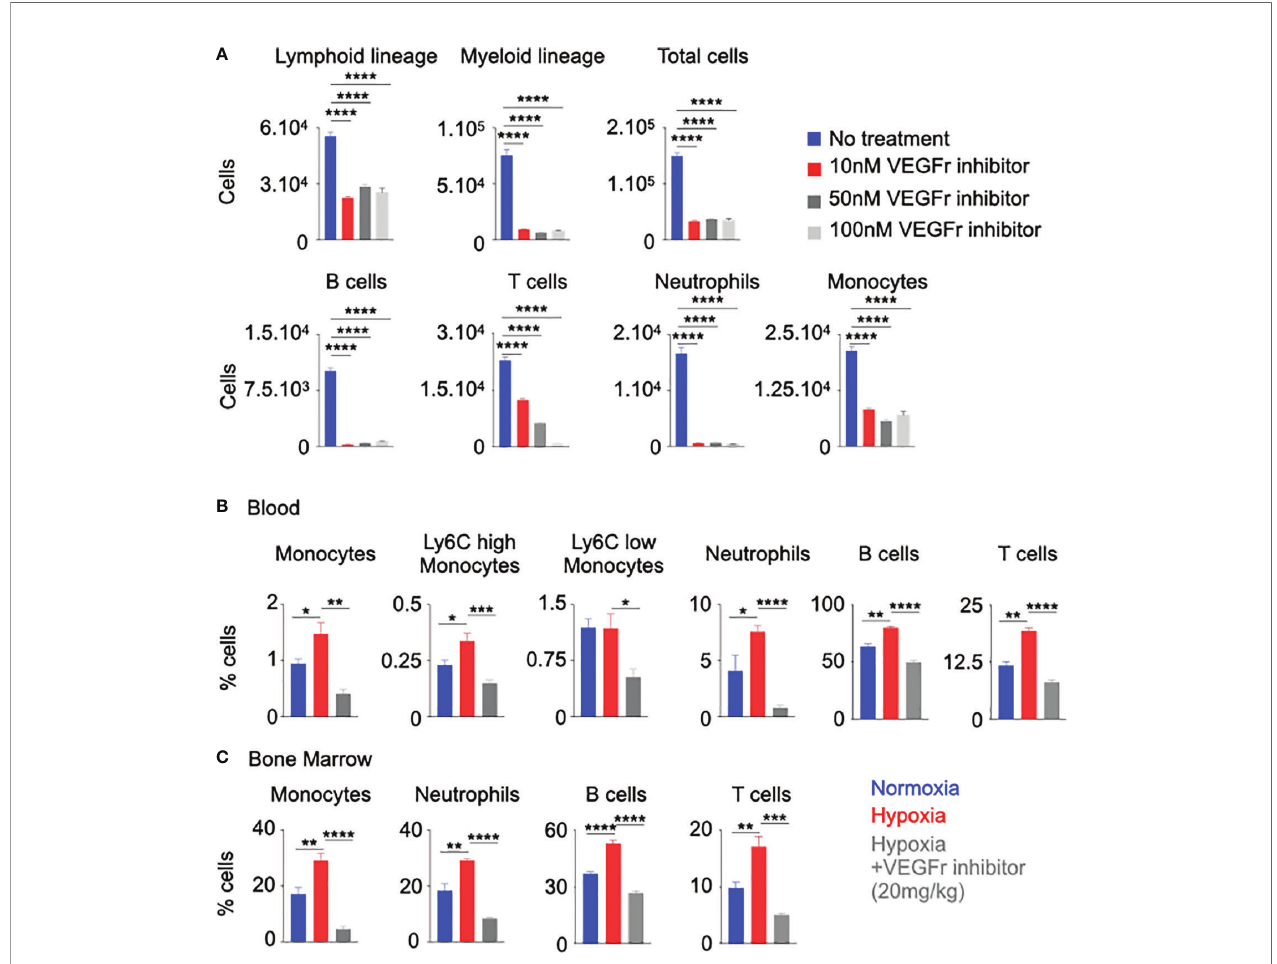
FIGURE 5 | Vegfr inhibition decreased in fl ammation in hypoxia. (A) Mouse HSPC were treated with increasing amounts of a Vegfr inhibitor (SU5416, 10- 100nM) or vehicle diluent (no treatment). Lineage commitment of HSPC was assessed by fl ow cytometry. B&C) C57BL/6 mice were treated with either a Vegfr inhibitor (SU5416) or vehicle diluent and placed in hypoxia for 21 days. Bone marrow and blood leukocytes were analyzed using fl ow cytometry. Percentages of blood (B) and bone marrow (C) monocytes and neutrophils were ascertained. n = 5 replicates or mice per condition. Data are shown as mean ± s.e.m. *P < 0.05, **P < 0.01, ***P < 0.001, ****P <